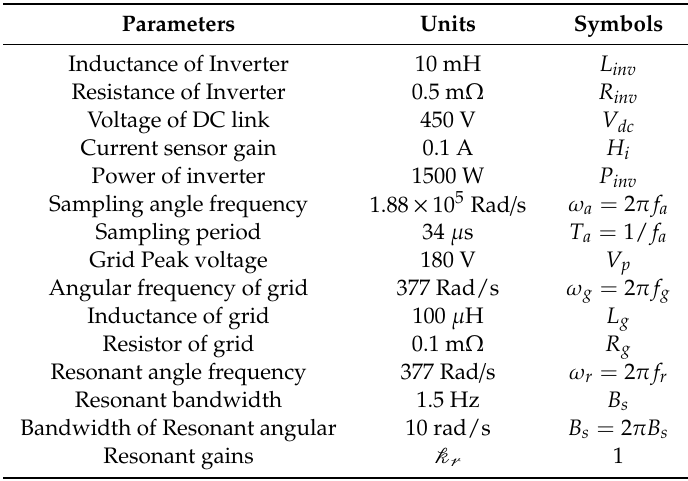
Table 5. Case study parameter value.